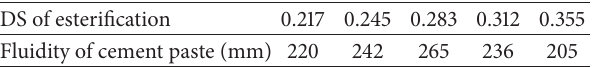
Table 4: Effect of the DS of esterification on the fluidity of cement